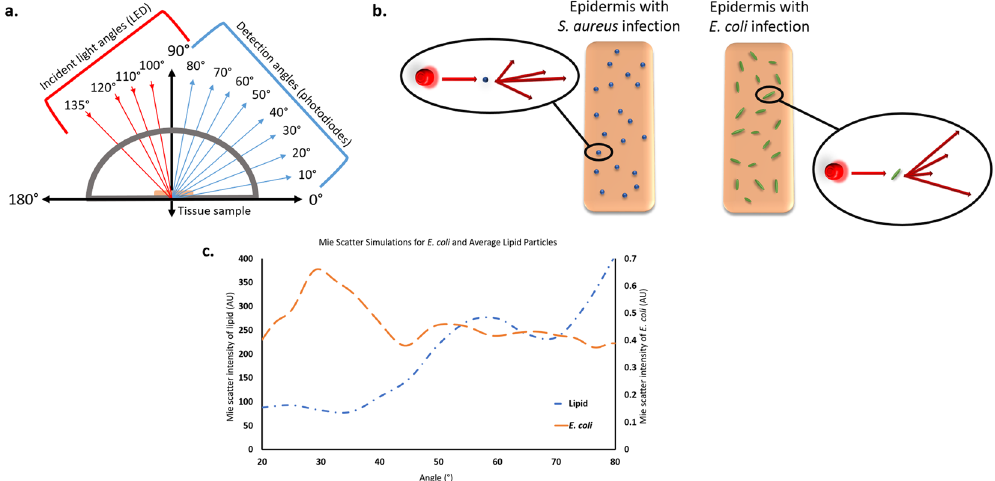
Figure 1. Schematic of Mie scatter spectra-based identification of bacteria. ( a ) Definition of incident light and detection angles for this work. All angles are defined relative to the tissue sample being placed on the plane from 0° to 180°. ( b ) A schematic representation of the concept of different bacterial species generating unique Mie scatter spectra. Based on the size ( r ), shape, and refractive index ( n ) of the bacterial species, Mie scatter intensities will vary across a range of detection angles, with unique spectra being produced by each species. In this example, Staphylococcus aureus , small cocci, results in one unique Mie spectrum, while Escherichia coli , medium bacilli, results in its own unique Mie spectrum across a variety of angles. ( c ) Mie scatter simulations conducted using the size and refractive index of E. coli versus those of typical lipid particles, much like those found in the skin. Simulations of expected Mie scatter trends show that E. coli should be distinguishable from lipid particles found within skin based on the use of a 650 nm light source resulting in a major peak at 30°.